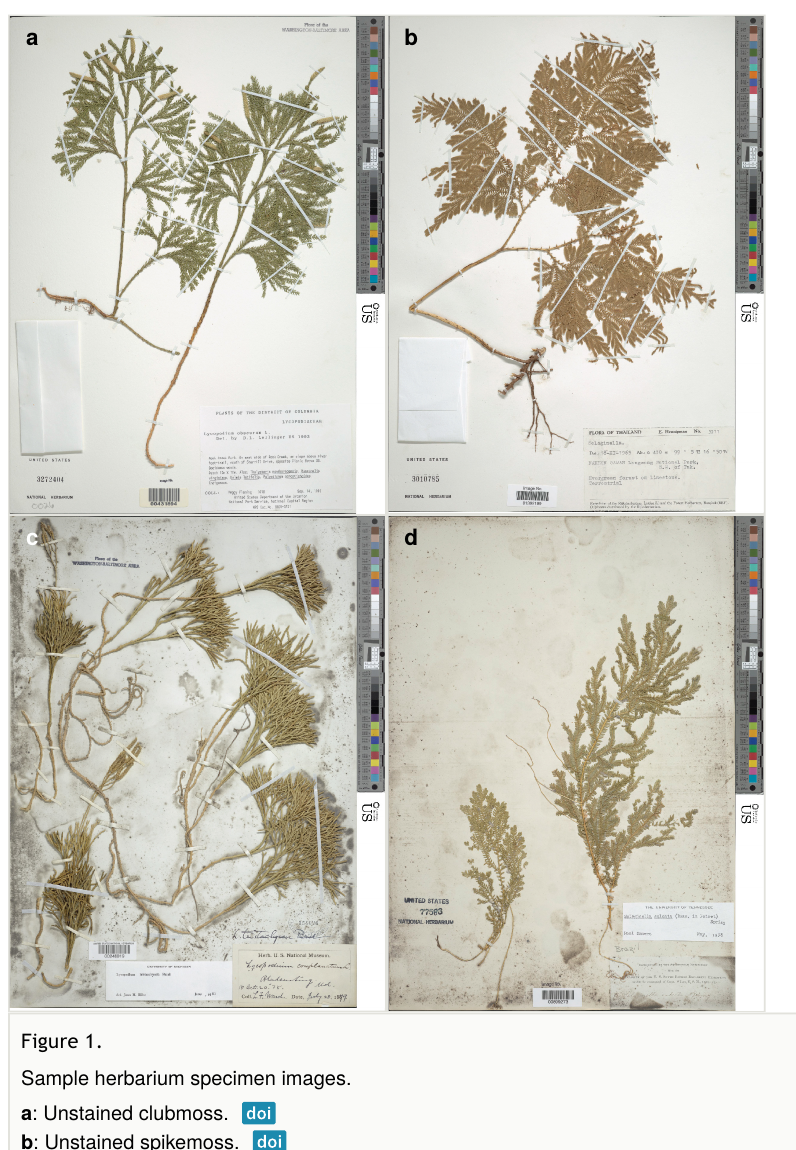
Figure 1. Sample herbarium specimen